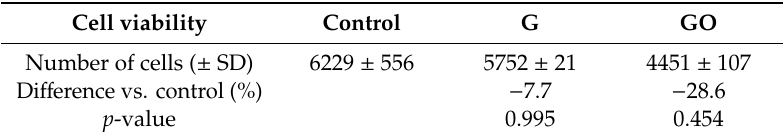
Table 4. Viability of the MC3-T3 cells (Mean ± SD) when directly exposed to control, GO-, and G-PMMA bone cements following an incubation period of 72 h.